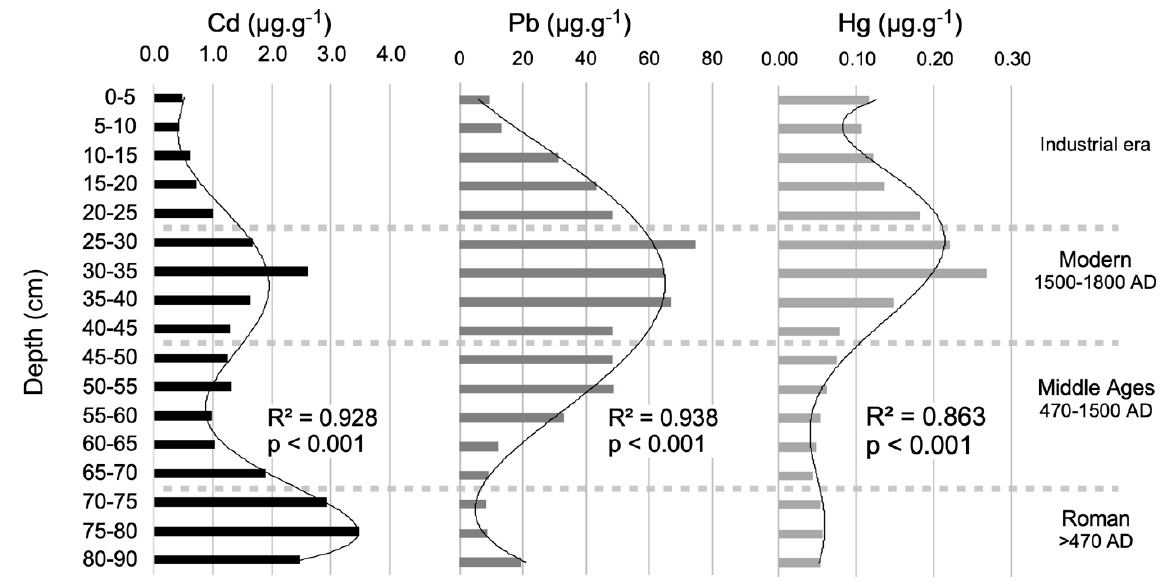
Figure 6. Concentration of the MTE cadmium (Cd), lead (Pb), and mercury (Hg) as function of peat depth.